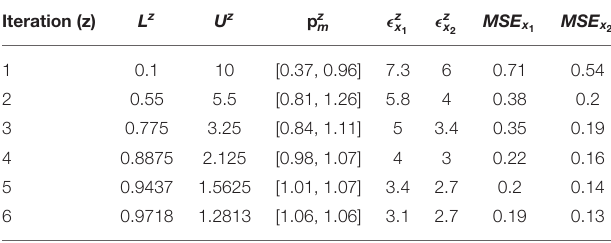
TABLE 3 | Tuning parameters and results of CRC in model M1. Iteration